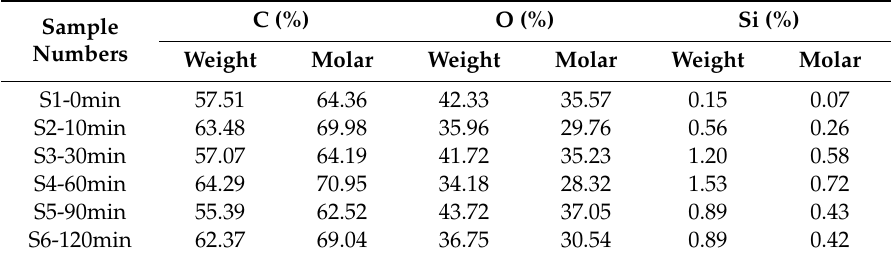
Table 2. The elements and their contents for unmodified and KH-560-modified jute